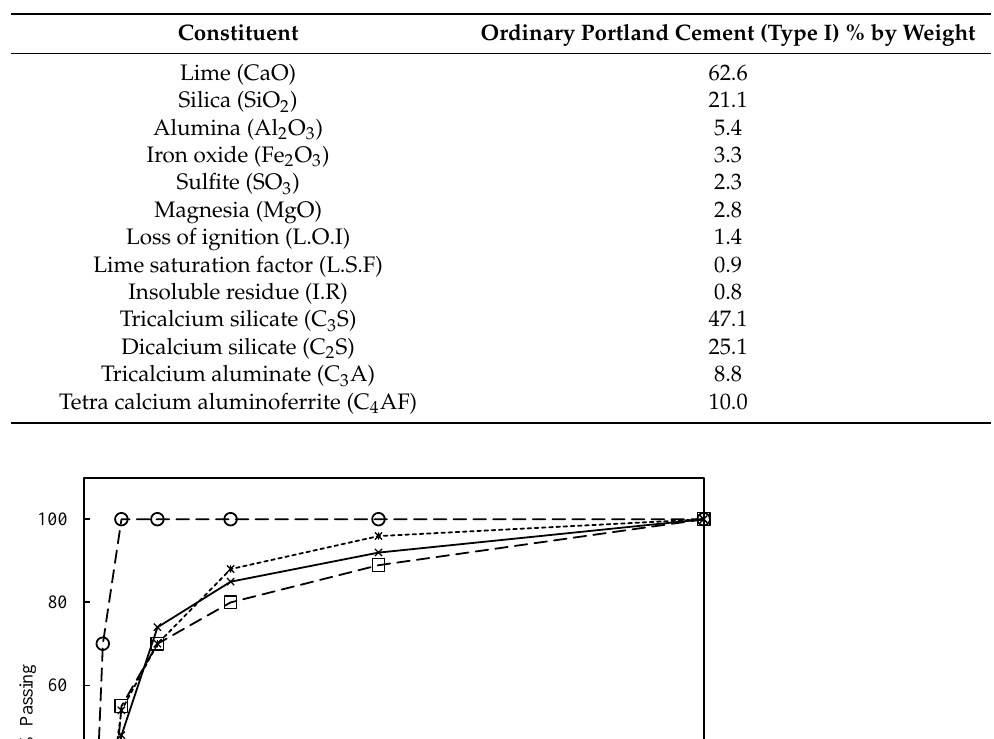
Table 1. Composition of ordinary Portland cement (Type I) used in concrete mixes.